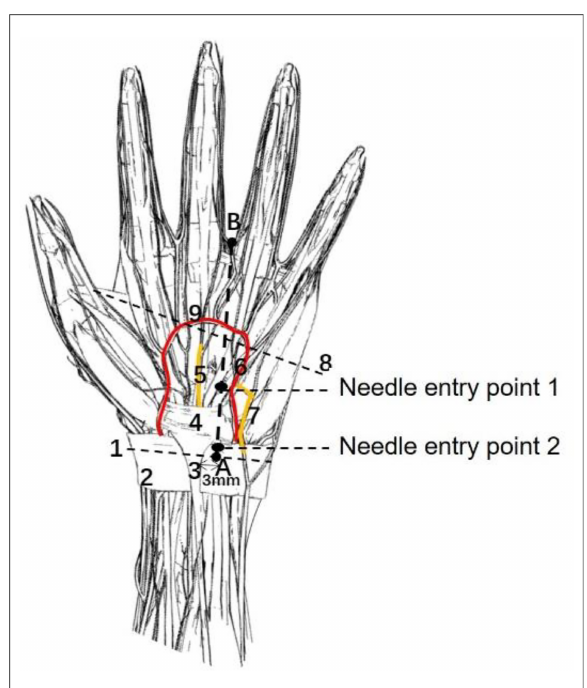
FIGURE 3 A schematic diagram of the needle entry point and the surrounding anatomical structure. 1, Proximal transverse carpal striae; 2, Super fi cial transverse palmar ligament; 3, Palmar longus tendon; 4, Transverse carpal ligament; 5, Median nerve; 6, Ulnar artery; 7, Ulnar nerve; 8, Kaplan line; 9, Palmar Super fi cial arch; ( A ) the intersection of the palmar longus tendon with 3 mm lateral to the ulnar side and the transverse stripes of the proximal wrist; ( B ) the intersection of the ring fi nger and the middle fi